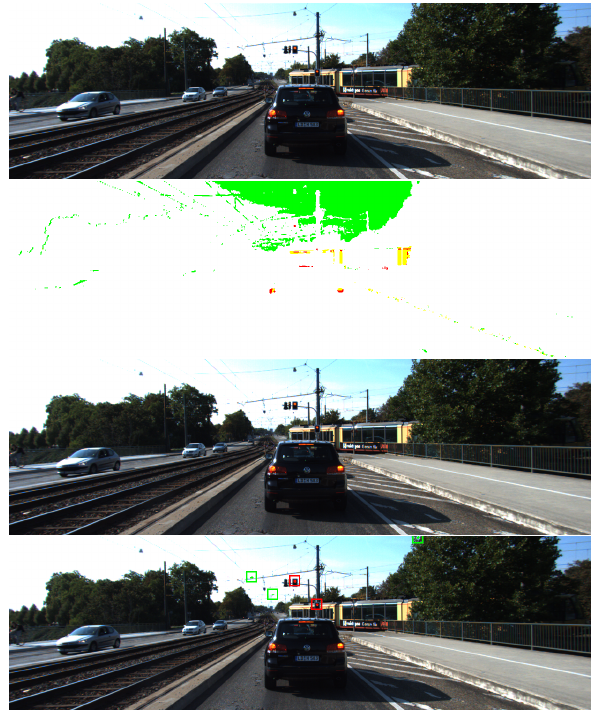
Figure 11: The traffic light detection algorithm is evaluated for a challenging scenario where the traffic light is far from the camera and their resolution is low in the images. Mono camera based ap- proach (third row) is not able to correctly detect the traffic lights are there are a few false positives. The stereo camera (fourth row) can correctly detect the traffic lights however there are few false